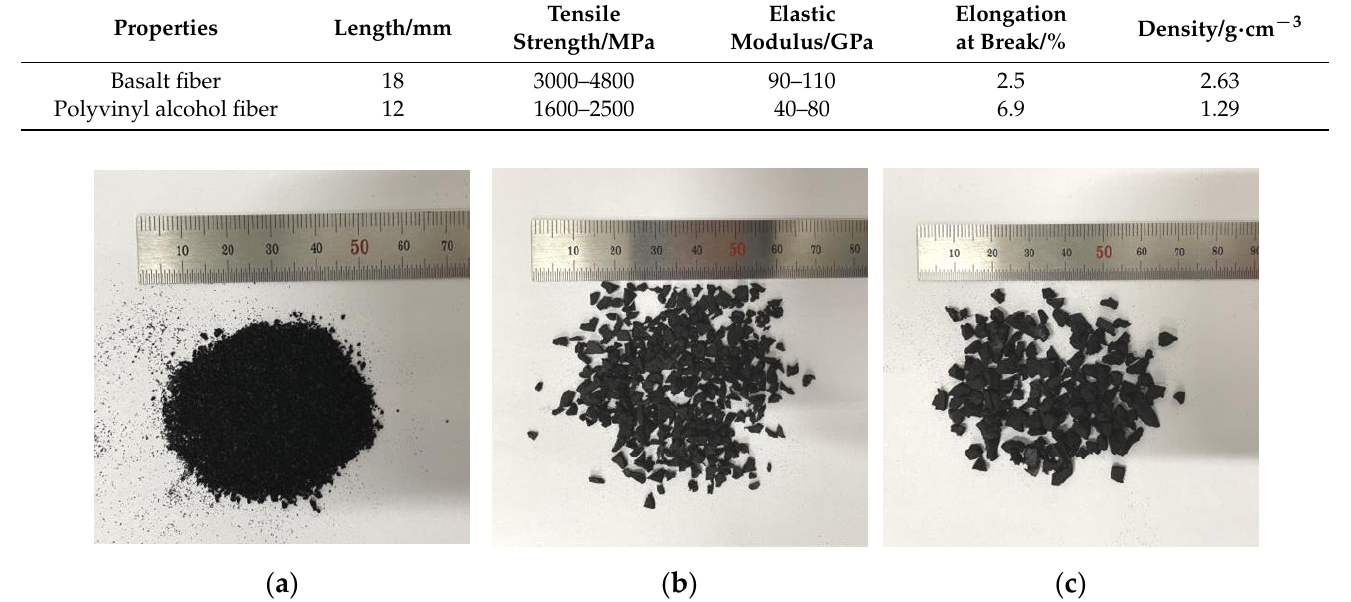
Figure 1. The appearance of rubber particle with the size of ( a ) 0.85 mm; ( b ) 1–3 mm; ( c ) 3–6 mm. Table 5. The physical properties of basalt fiber and polyvinyl alcohol fiber.